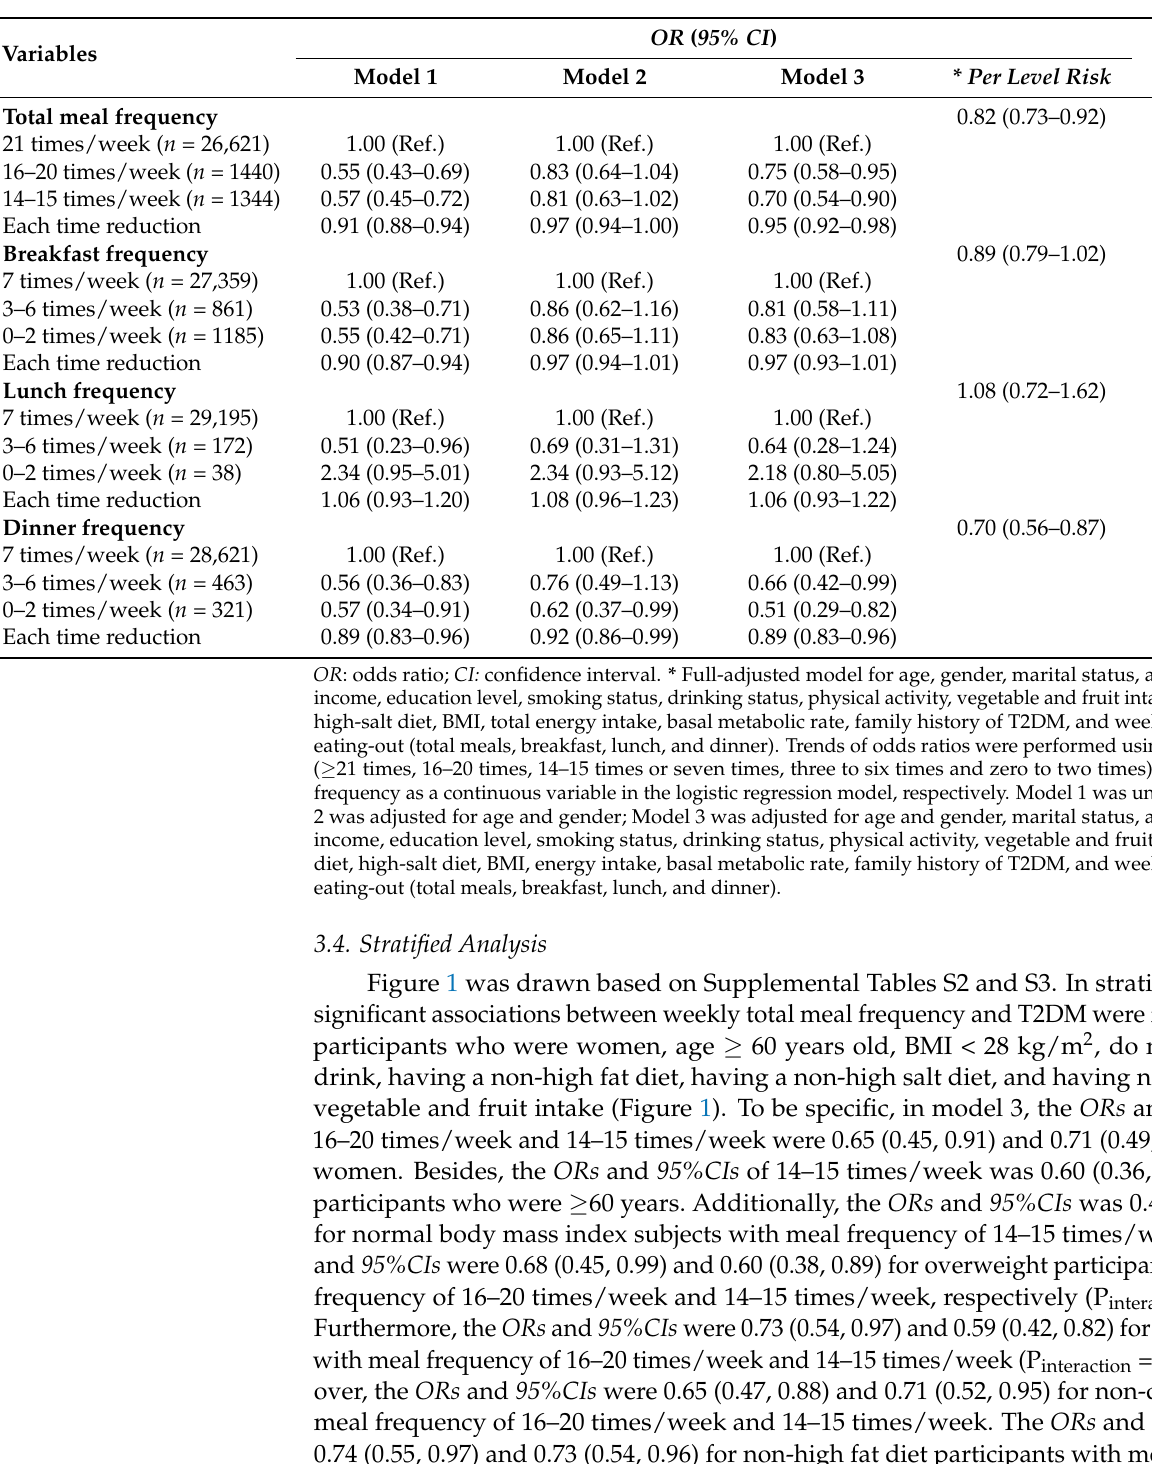
Table 2. Multivariate-adjusted ORs and 95%CIs for T2DM according to weekly meal